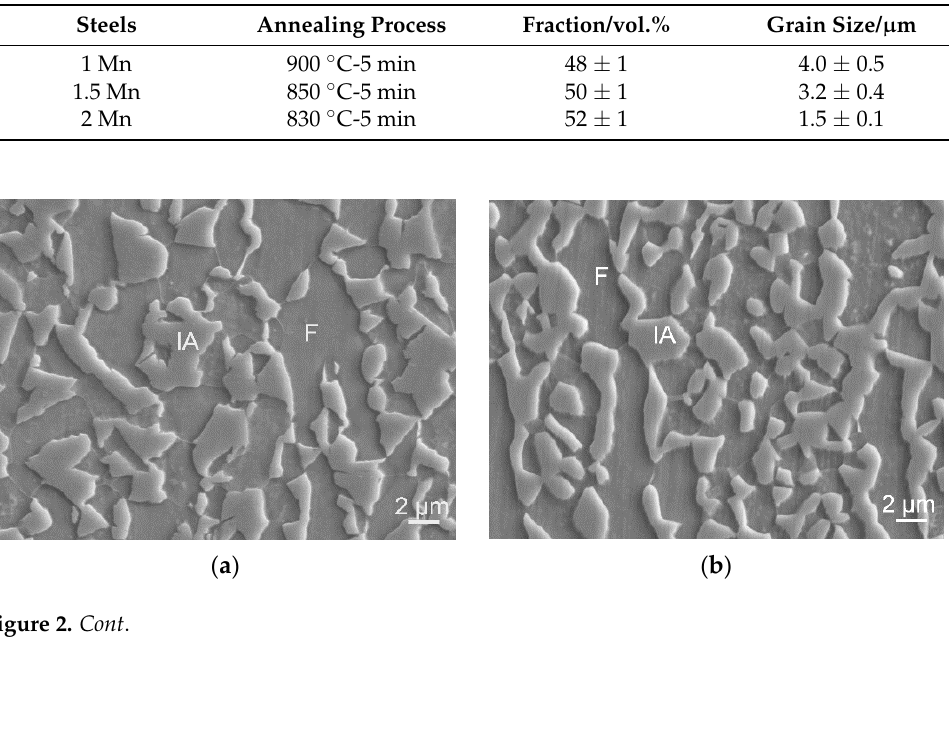
Table 2. Fraction and grain size of prior austenite measured by image analyses.